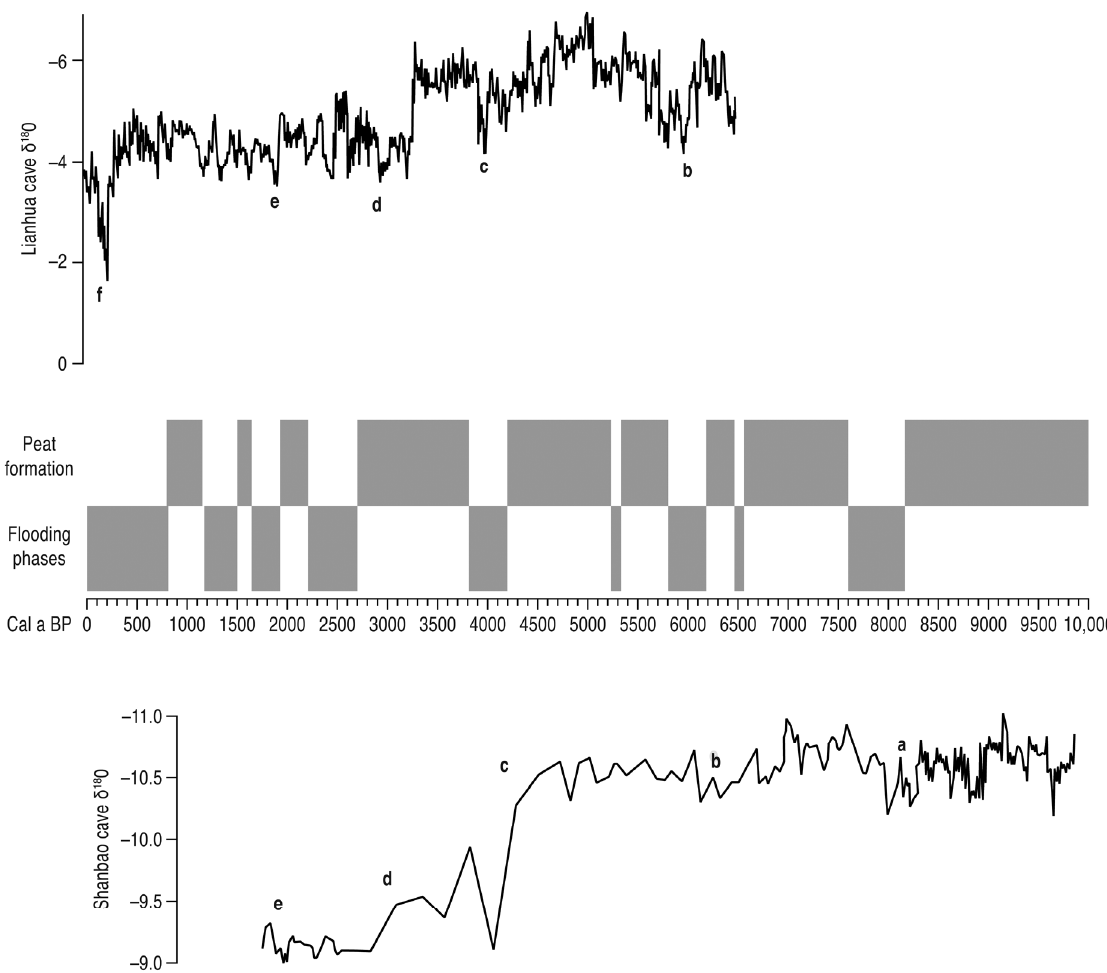
Figure 6. Phases of flooding and peat formation in the Lower Yangtze valley/Taihu lowland region, derived from Tables 2 and 3. Two graphs of temperature fluctuations (and monsoon precipitation) during the Holocene in eastern China are also shown, derived from Cosford et al. [242] at Lianhua Cave and Shao et al. [239] at Shanbao Cave, which is the δ 18 O record closest to the Taihu lowland and at the same latitude. Major climatic deterioration events are dated to (a) 8.2 (b) 6.2 (c) 4.2 (d) 2.8 (e) 1.8 cal. ka BP and (f) since c.500 cal. BP (Little Ice Age).